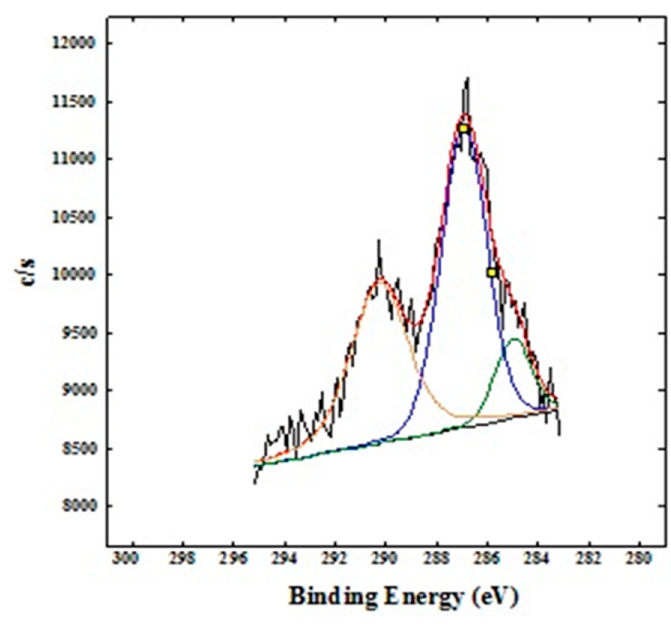
Figure 4. XPS spectrum for the C1s region for the compound Bi 2 O 2 CO 3 :Al. Table 3. Atomic concentrations and assignments for the C1 s region for the compound Bi 2 O 2 CO 3 :Al. Bond Energy for C1 s